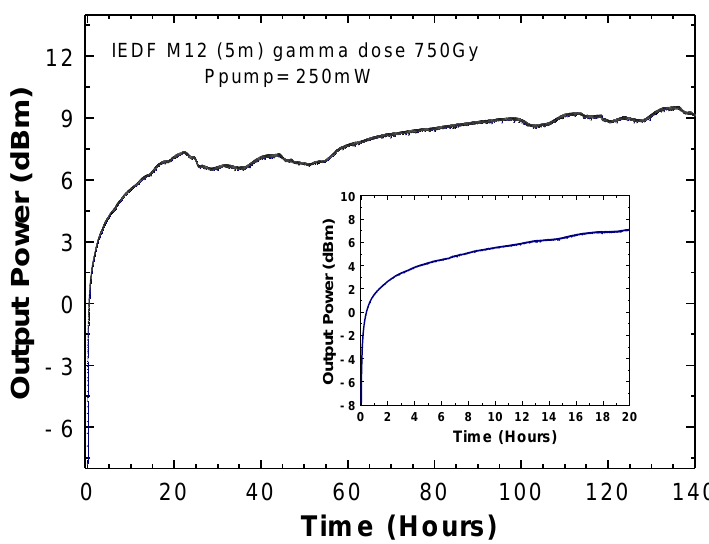
Figure 8. Output power variation over 140 h when using 5 m of an IEDF M12 with 750 Gy when pumped with 250 mW. Inset: detail of the first 20 h of pumping.